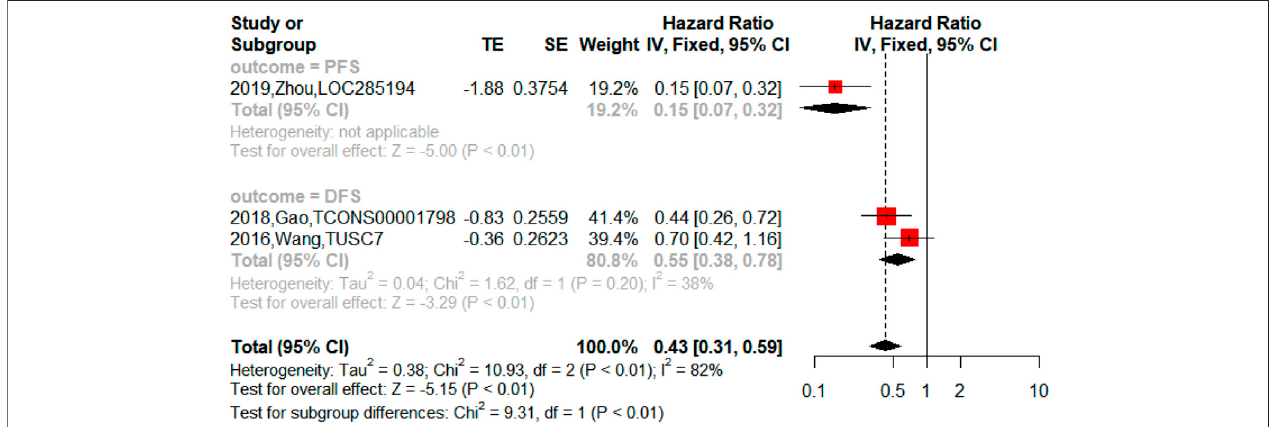
FIGURE 6 | Forest plots of the association between downregulated lncRNAs and PFS and DFS in NSCLC.